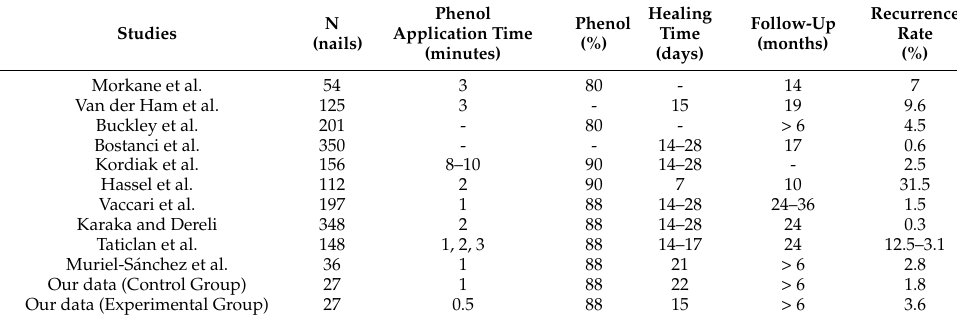
Table 2. Studies of the Phenol Chemical